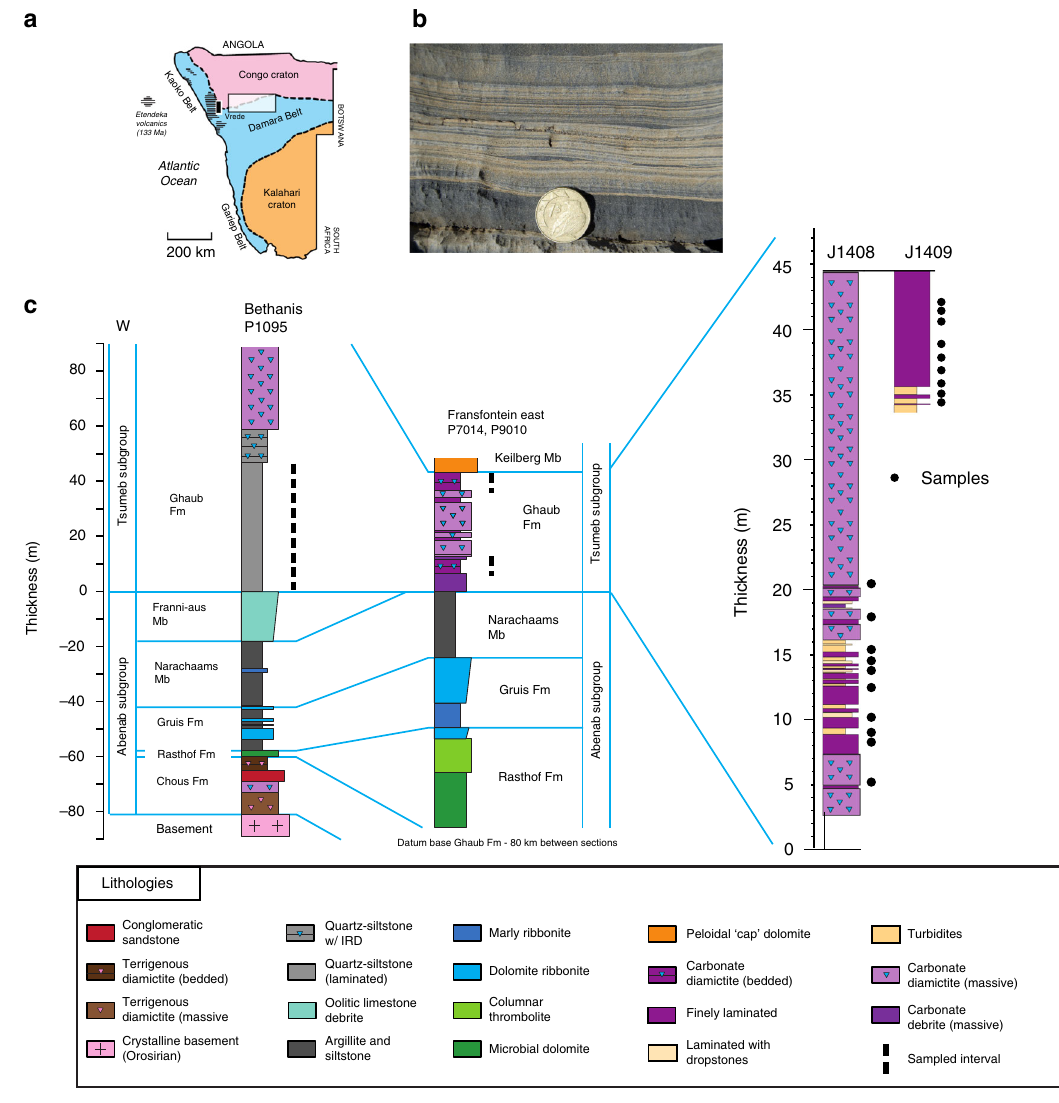
Fig. 1 Geologic setting and sample locations. a Location map 49 , b typical sample photo from section J1408, and c stratigraphy of studied sections. Fransfontein section is from ref. 24 , and Bethanis section is from ref. 26 . Detailed section at Fransfontein highlights samples taken from only fi nely laminated beds without ice rafted debris or turbidites. Samples at Bethanis were taken at about 10 m spacing throughout the marked section. Sample section abbreviations are SGS (synglacial siliciclastic), SGC (synglacial with carbonate) and DGC (deglacial